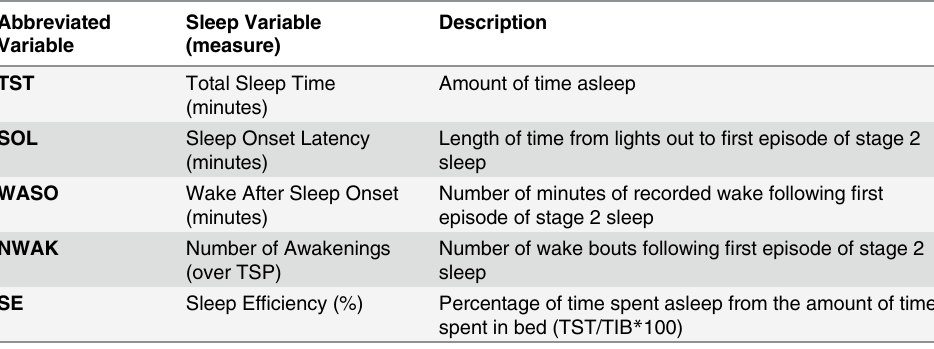
Table 1. Description of sleep